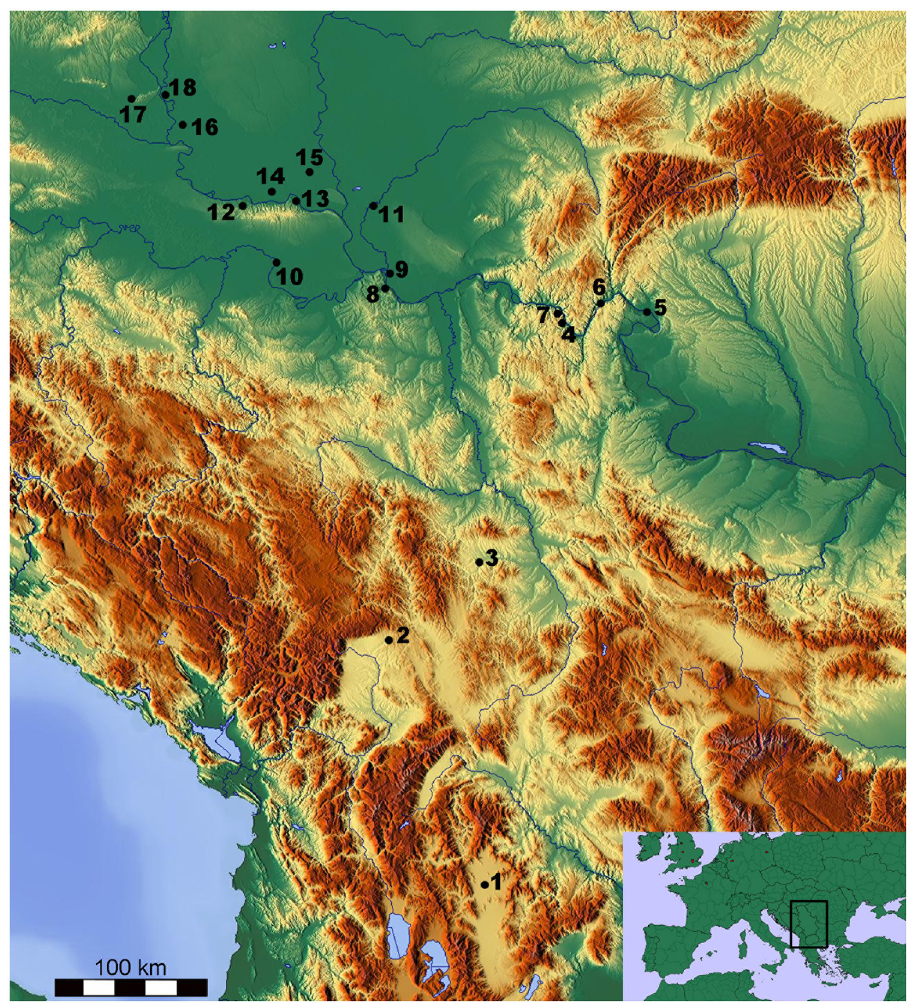
Fig 1. Partial map of the Balkan Peninsula. Sites mentioned in the text: 1-Vrbjanska Č uka, 2-Rudnik Kosovski, 3-Plo č nik, 4-Lepenski Vir and Vlasac, 5-Ajmana, 6-Hajdu č ka Vodenica, 7-Padina, 8-Vin č a, 9-Star č evo-Grad, 10-Gomolava, 11-Rutonjina Greda, 12-Golokut Vizi ć , 13-Sremski Karlovci, 14-Sajlovo, 15-Gospo đ inci, 16-Magare ć i Mlin, 17-Popova Zemlja, 18-Ba č ki Monosˇtor (base map credit: © OpenStreetMap contributors, available under the Open Database